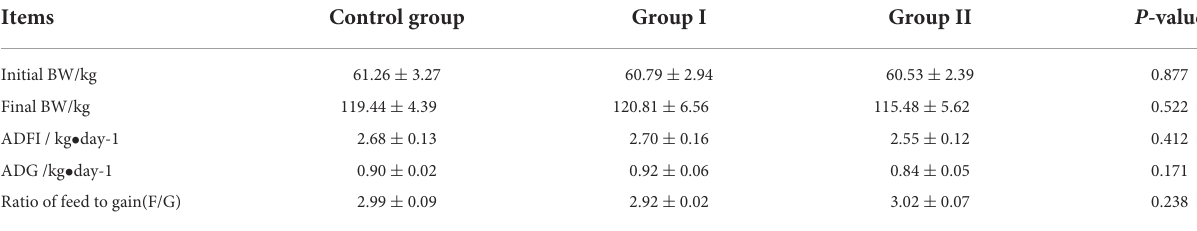
TABLE 3 Effect of dietary protein level on growth performance in finishing pigs. Items